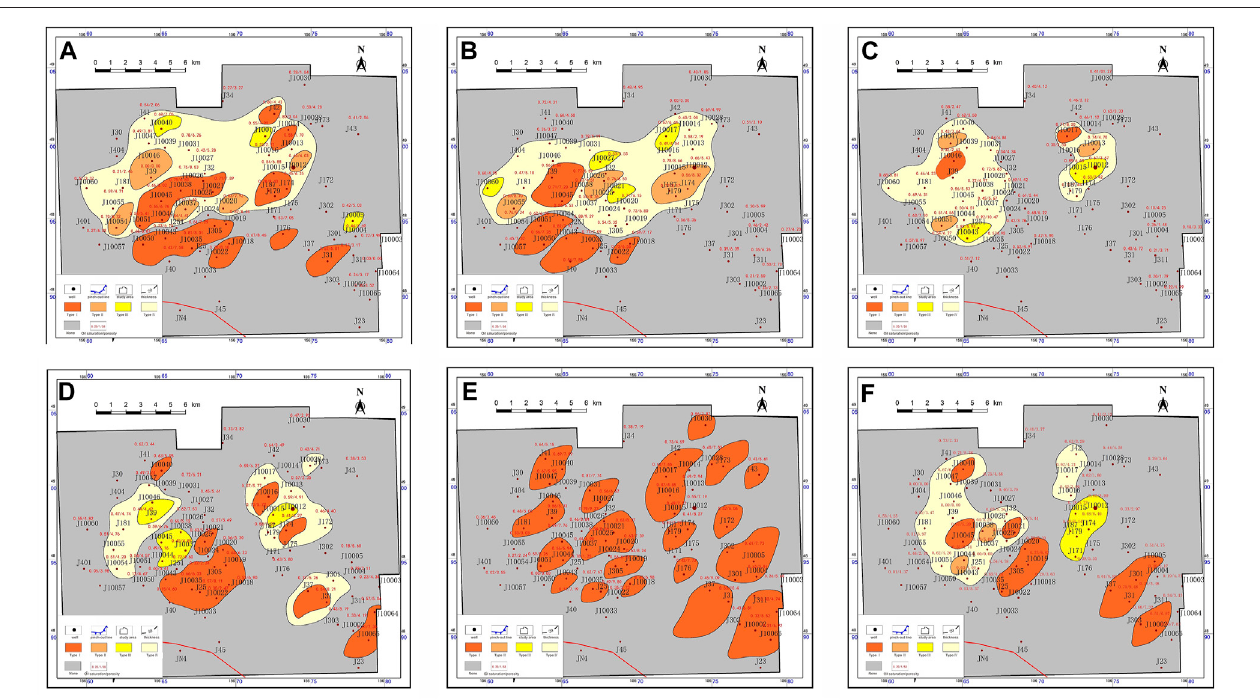
FIGURE 12 | Sweet spot plane distribution of the Lucaogou Formation in the Jimsar Sag. (A) Sweet spot plane distribution of P 2 l 12 − 3 . (B) Sweet spot plane